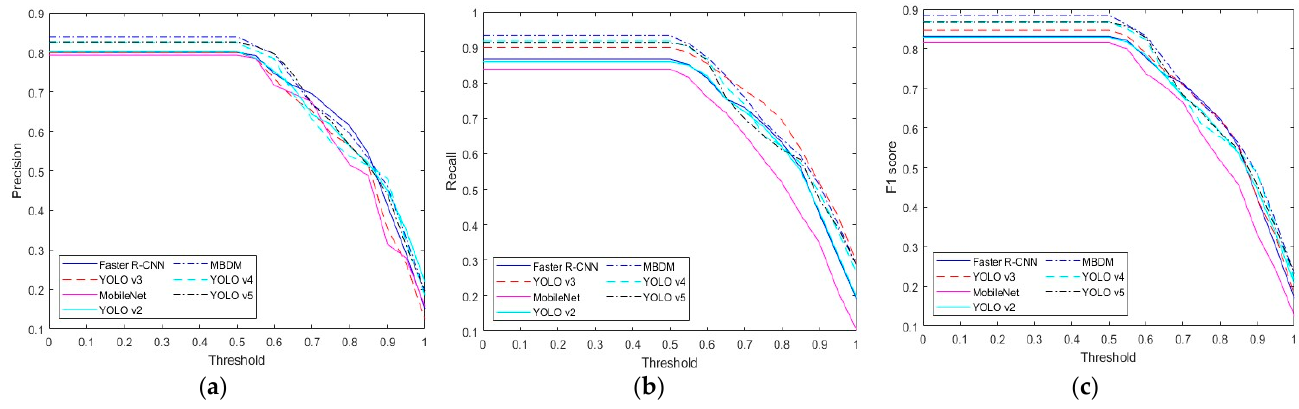
Figure 7. Performance comparison graph for each method according to IoU threshold in multinational banknote database: ( a ) precision, ( b ) recall, and ( c ) F1 score.